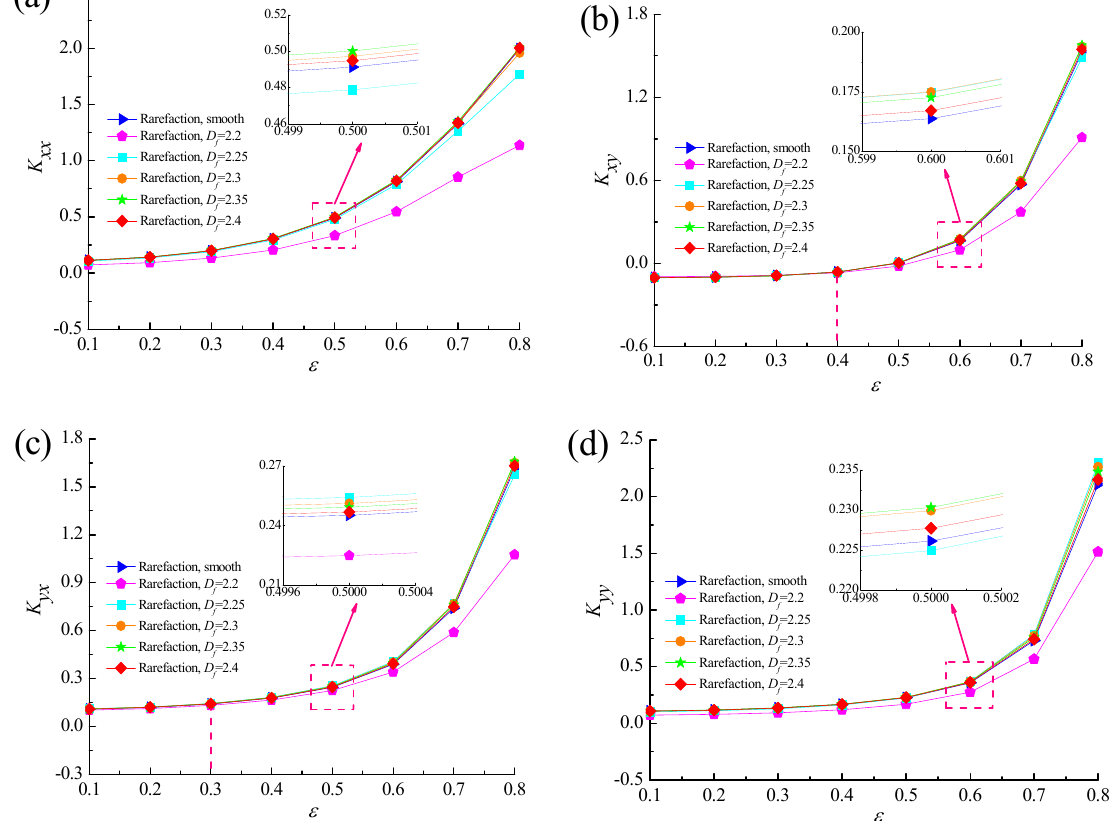
Figure 14. Effect of eccentricity ratio on dynamic stiffness coefficients with different fractal